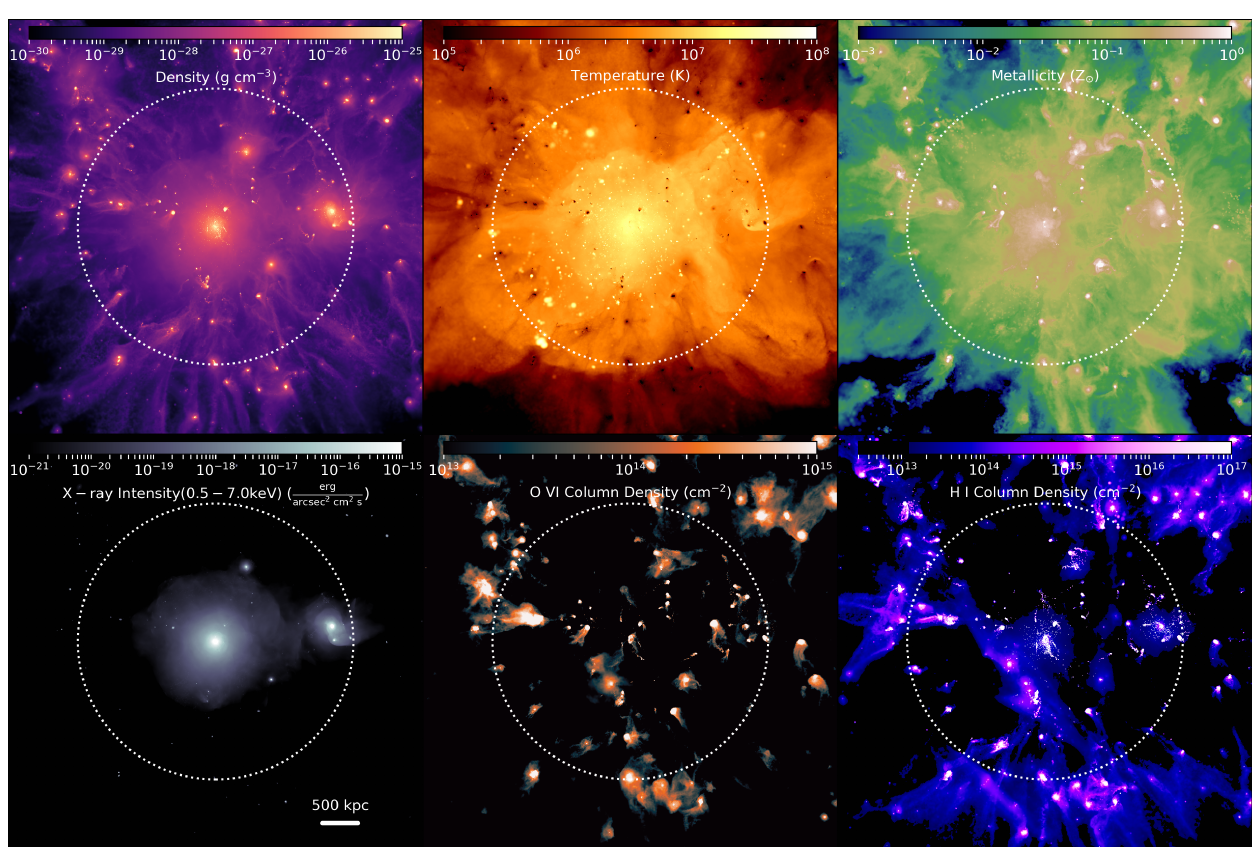
Figure 11. The ROMULUSC simulation at z = 0.31 [19]. The top row shows the projected density, temperature, and metallicity. The bottom row shows the predicted X-ray emission as well as the O VI and H I column densities. Each image spans 5 Mpc across and the white dashed circle has a radius of 3 R 500 . X-ray emission probes the inner hot, dense region of the IGrM. UV absorption of ions like O VI and H I provide a highly complementary view of the IGrM, tracing the filamentary structure of cool and warm gas as it is stripped from its host